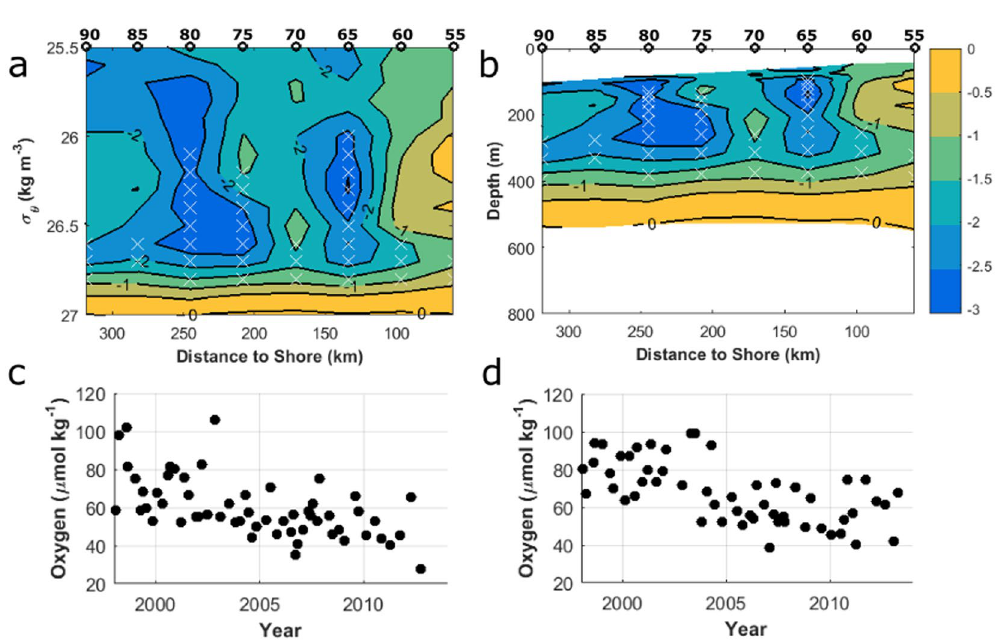
Figure 3. The rate of change in dissolved oxygen concentration ( µ mol kg − 1 year − 1 ) from 1998–2013 ( a ) on isopycnals ( σ θ 25.5–27.0 kg m − 3 ) and ( b ) on depth. The rate of change was calculated along isopycnals and is plotted over the average depth of each σ θ from 25.5–27.0 kg m − 3 . In both, white crosses mark statistically significant correlations (p < 0.01, corrected for autocorrelation) while black circles mark hydrographic stations. ( c ) The observations of dissolved oxygen on σ θ 26.7 at station 65 and (d) the observations of dissolved oxygen on σ θ 26.7 at station